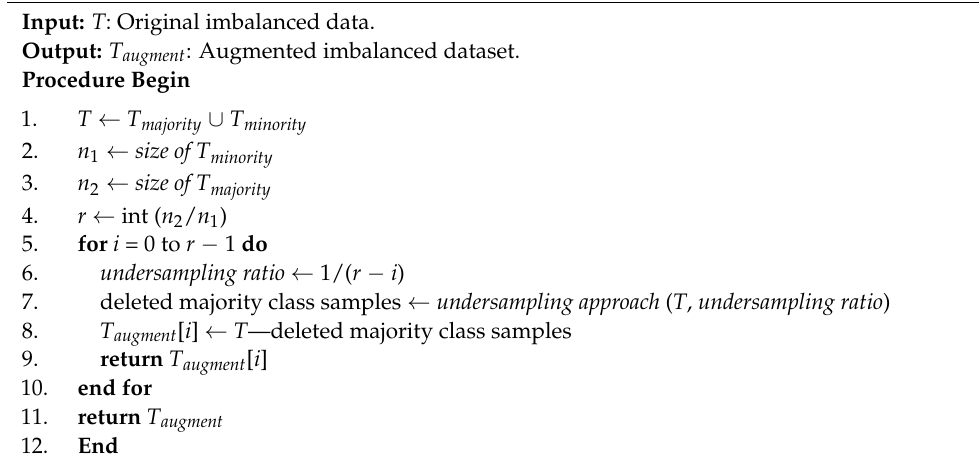
Figure 2. Relationship between the augmentation process and IR change in Algorithm 1. Then, the imbalanced data augmentation algorithm based on the undersampling method is introduced. After applying Algorithm 2, the augmented imbalanced dataset with decreasing IR can be obtained. Algorithm 2 Undersampling based imbalanced data